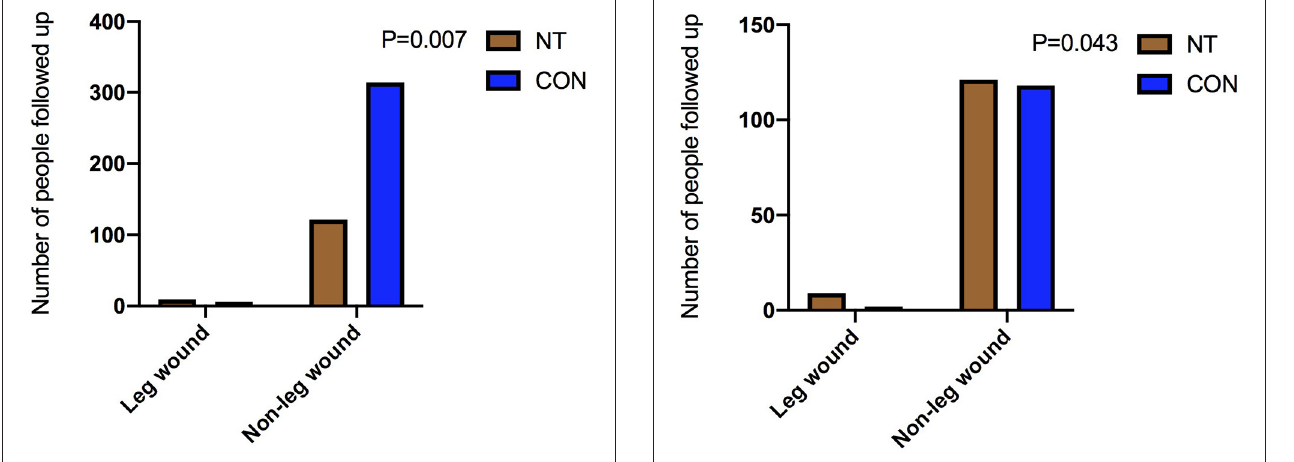
FIGURE 6 | Comparison of leg wounds before matching. FIGURE 7 | Comparison of leg wounds after